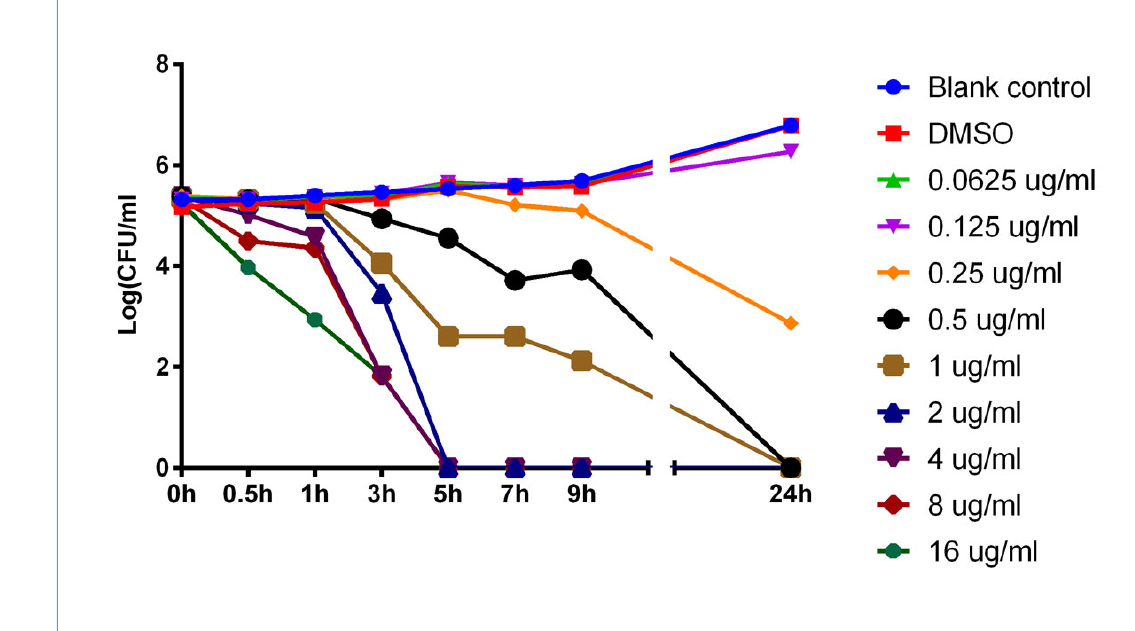
Figure 1: Time-kill kinetics of TNP-2092. The higher the concentration of TNP-2092 was, the faster colony forming units (CFUs) were reduced (but not for concentrations of 2 and 4 µg/ml). In parallel, CFUs were also gradually decreased over time. When the concentrations of TNP was lower than the minimum inhibitory concentration (0.25 µg/ml) bacterial growth was